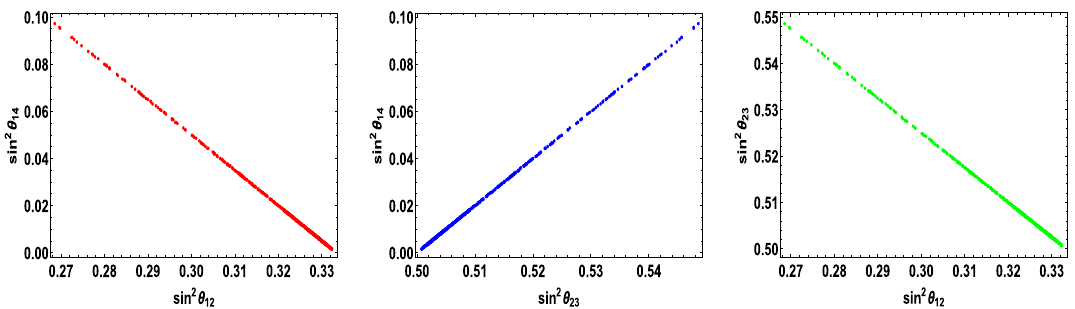
Fig. 1 Correlation of the active-sterile mixing angle θ 14 with solar mixing angle θ 12 (left panel), with atmospheric mixing angle θ 23 (middle panel) and between the atmospheric and solar mixing angles (right